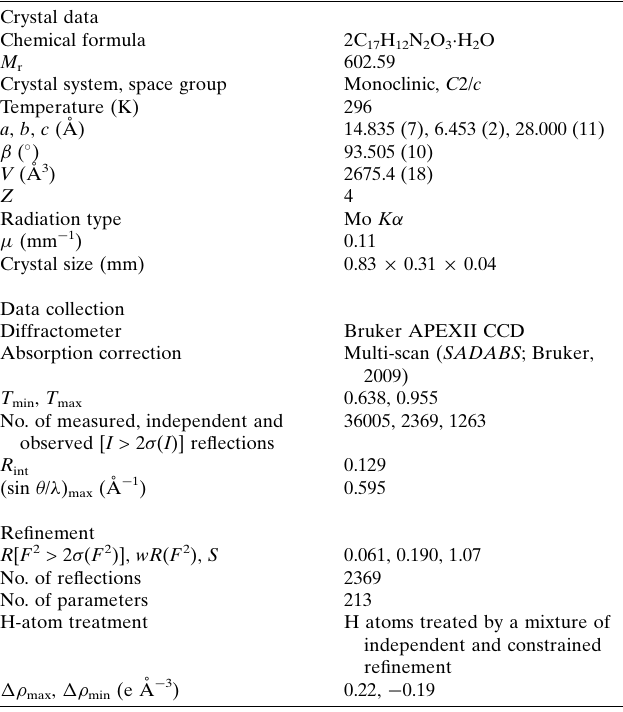
Table 2 Experimental details. Crystal data Chemical